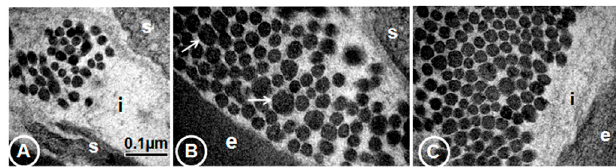
Figure 3. Photomicrographs of aortic wall sections from MA (A), OC (B) and OT (C) groups of rats stained with haematoxylin and eosin and taken with the same magnification. The OC group of rats (B) presented the highest aorta thickness, followed by the OT group (C).